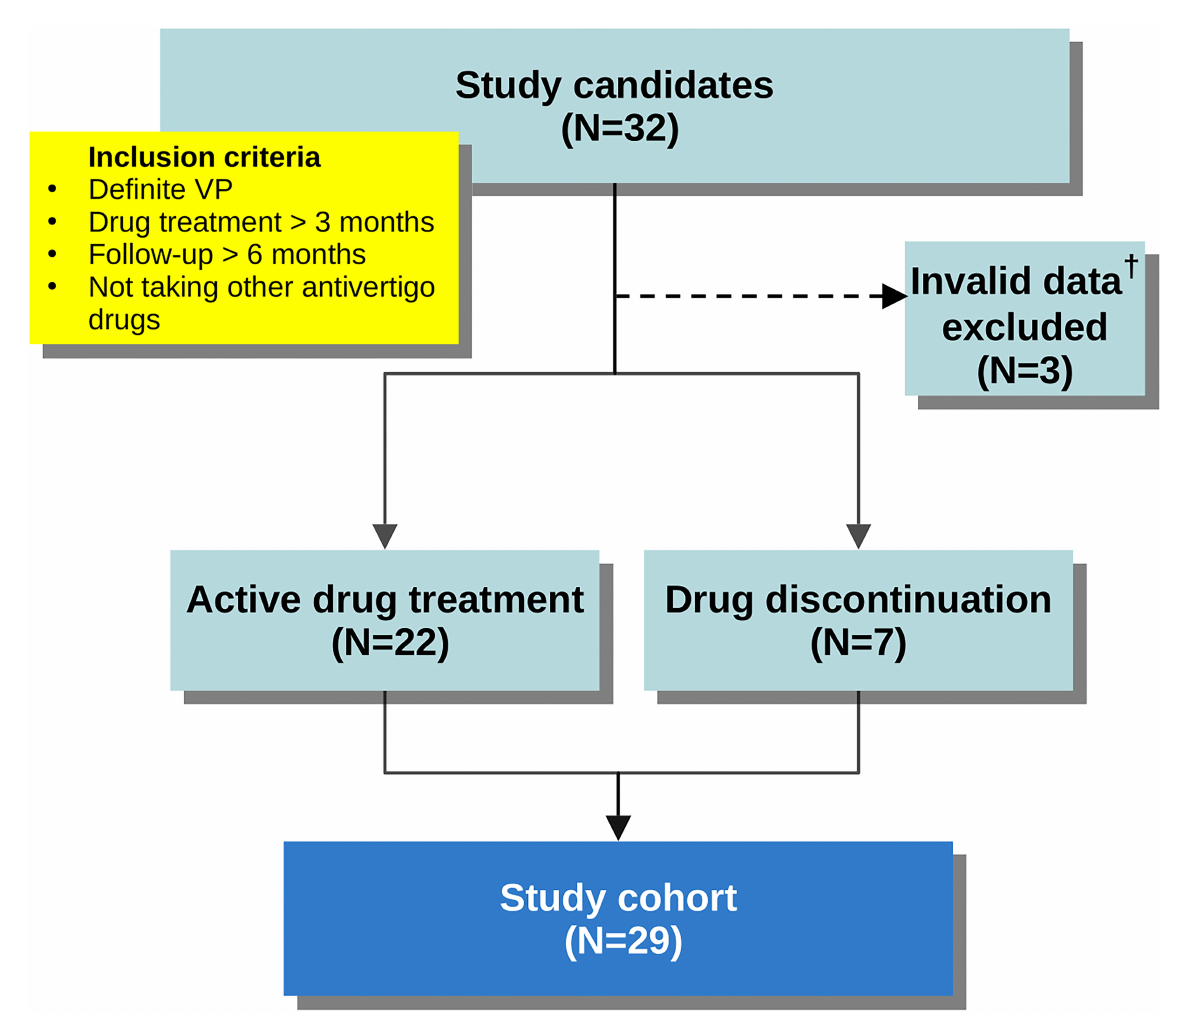
FIGURE1 Flowchart demonstrating cohort derivation. † Patient records that had not been updated in the last 3 months before study